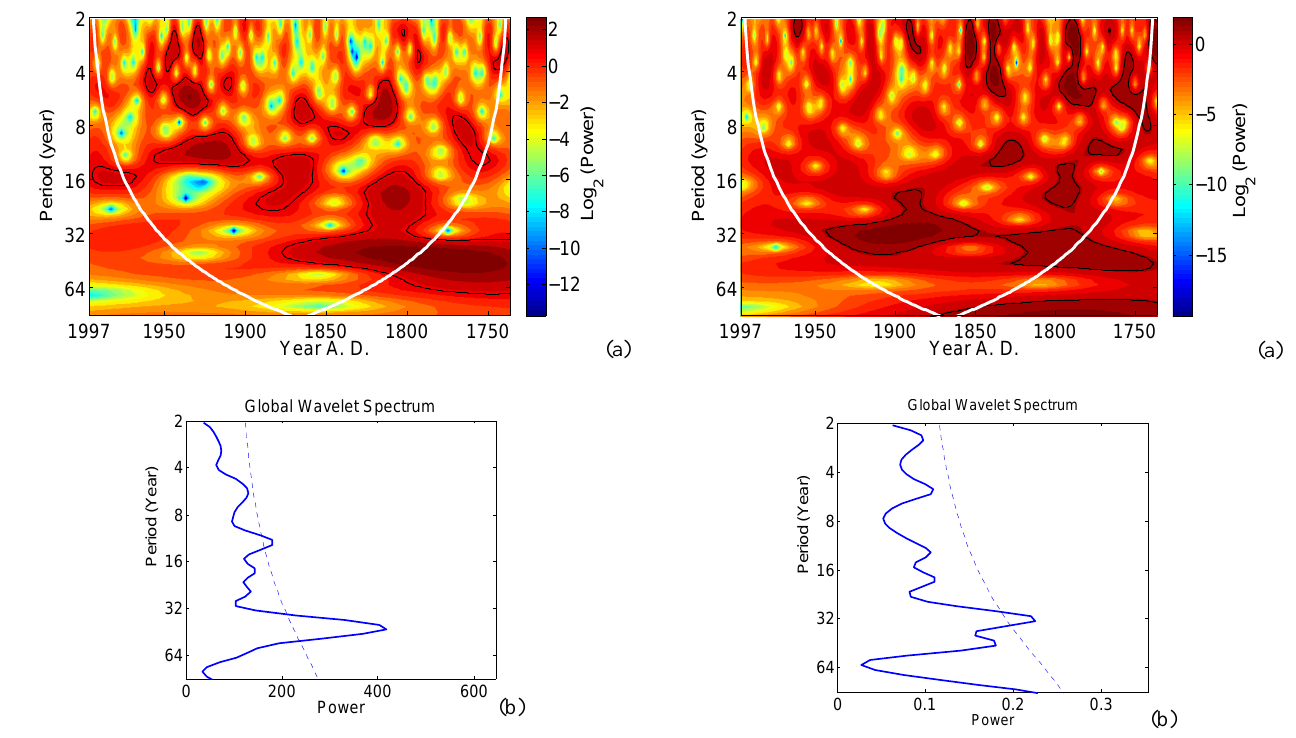
Fig. 8. a) Wavelet plot for reconstructed accumulation rates (Elmer/Ice): binary logarithm of the power (absolute square of the wavelet transform) in m 2 a − 2 . Black contours represent the 95% confidence level against red noise (Torrence and Compo, 1998). Ar- eas outside the cone of influence (indicated by the thick white line) are to be discarded. (b) Global wavelet spectrum for reconstructed accumulation rates (Elmer/Ice). The thin dashed line indicates the the 95% confidence level against red